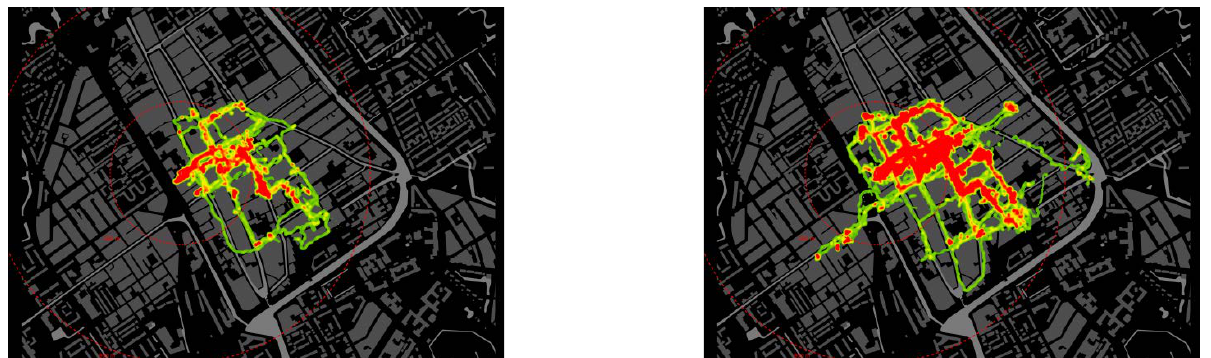
Figure 2. Tracking results of Tracking Delft (kernel density) based on origin of the visitor: unfamiliar -